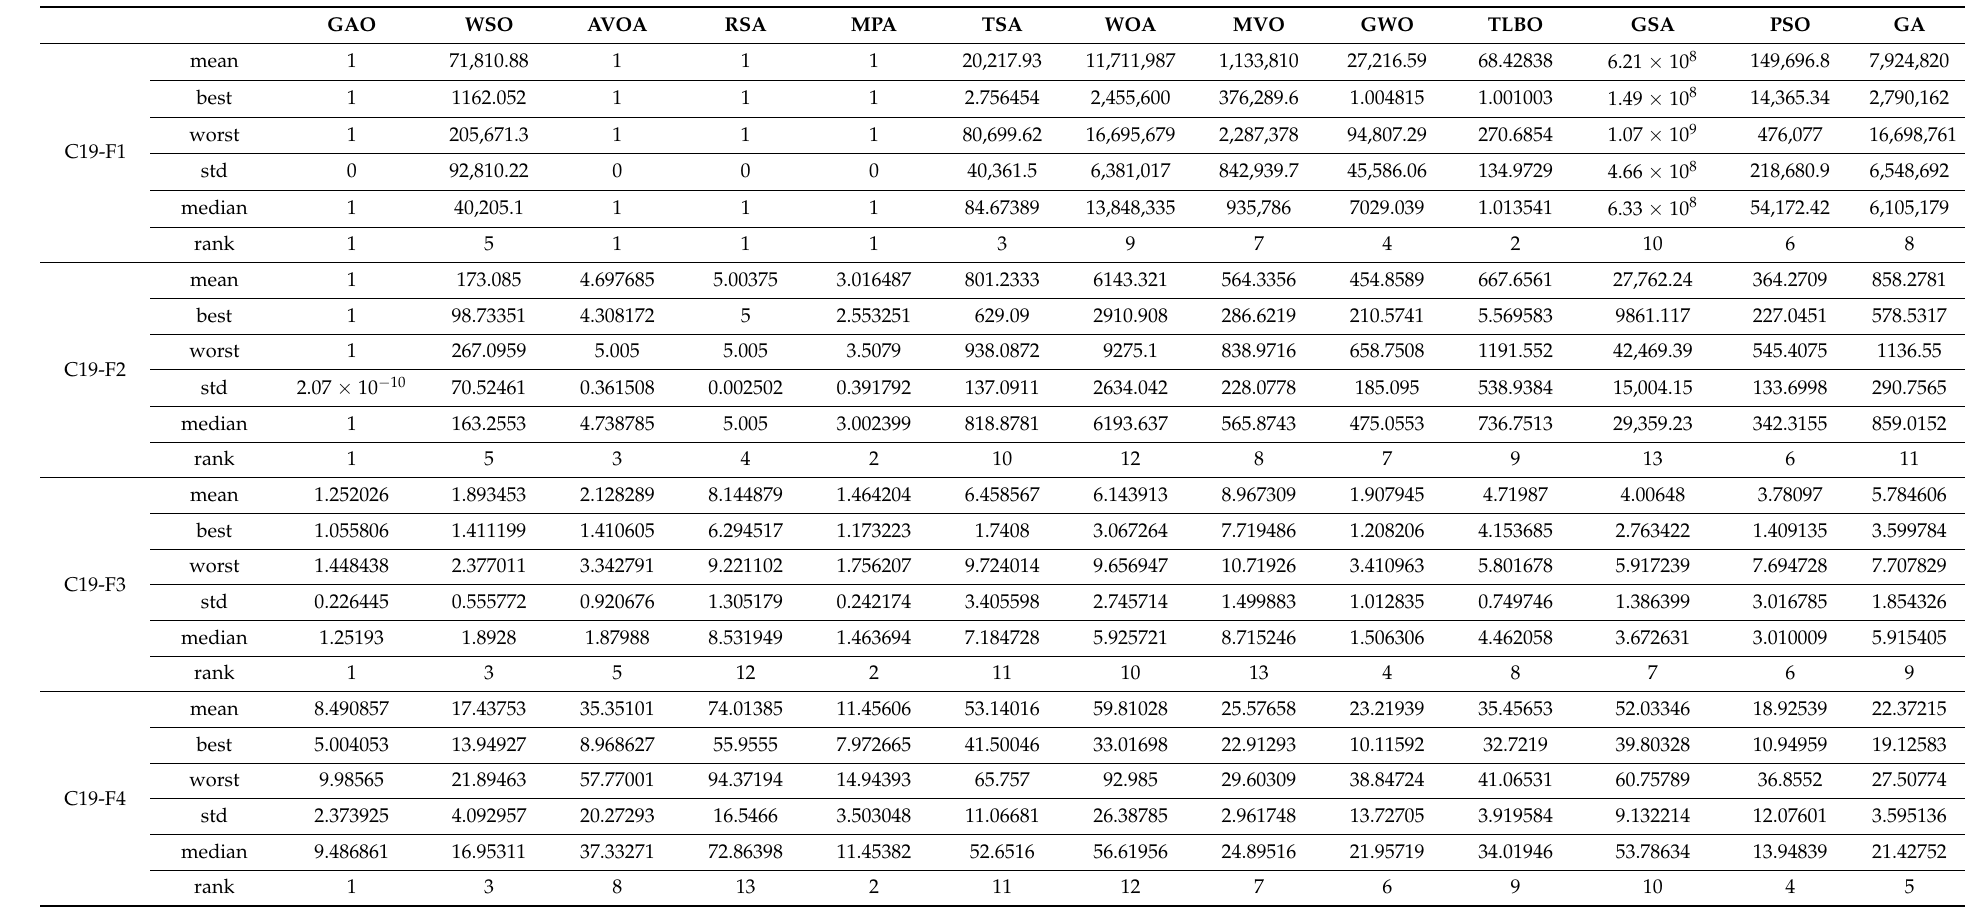
Table 6. Optimization results of the CEC 2019 test